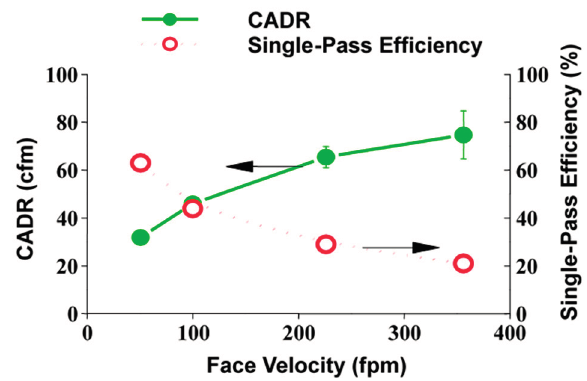
Figure 2. The effect of flow velocity on the effective CADR is opposite to the effect on SPE and gives a more accurate picture of the effect of air purification to HVAC professionals. A generic HVAC design is